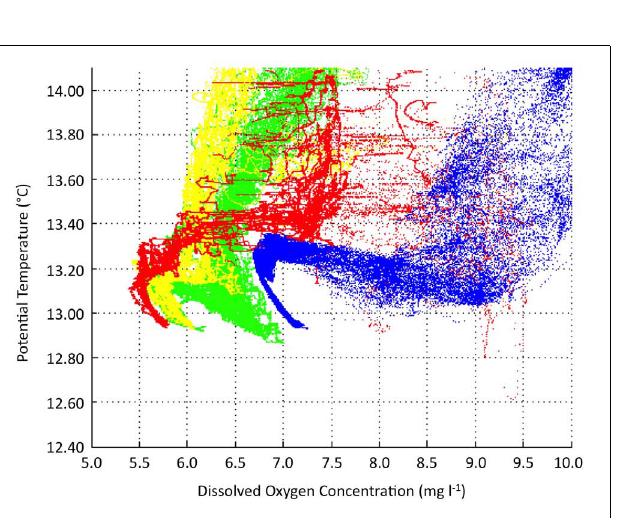
FIGURE 11 | A potential temperature/oxygen ( θ /O) diagram, showing the typical size of correction necessary for DM field correction of a glider mission (blue) to bottle calibrated ship CTD survey data (red, yellow,